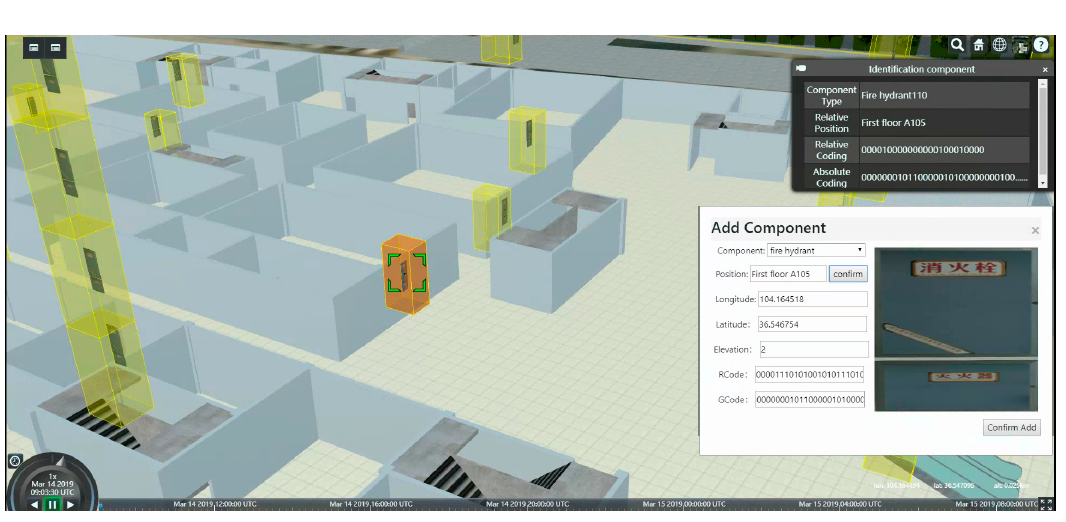
Figure 17. Accurately add fire hydrant components and inquire.